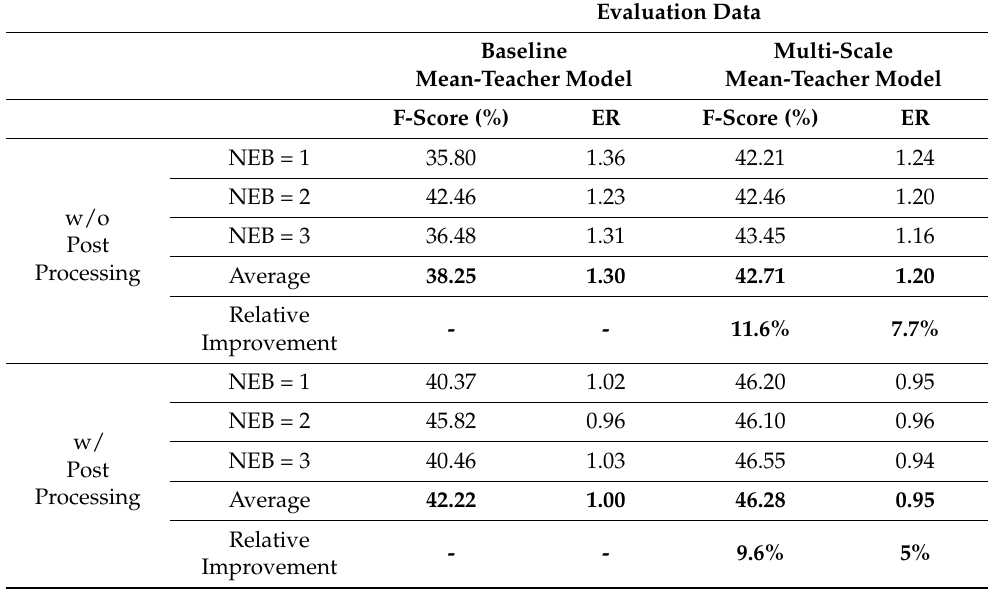
Table 6. Comparison of event-based SED results on evaluation data between baseline mean-teacher model and the proposed mean-teacher model with multi-scale